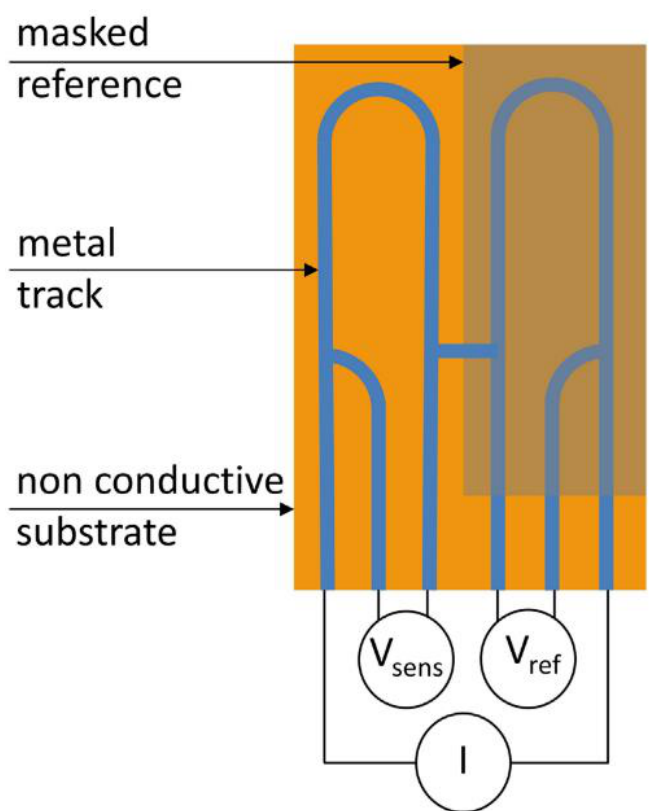
Figure 20. An ER probe (Reprinted with permission from ref. [78]. Copyright 2017 John Wiley and Sons).